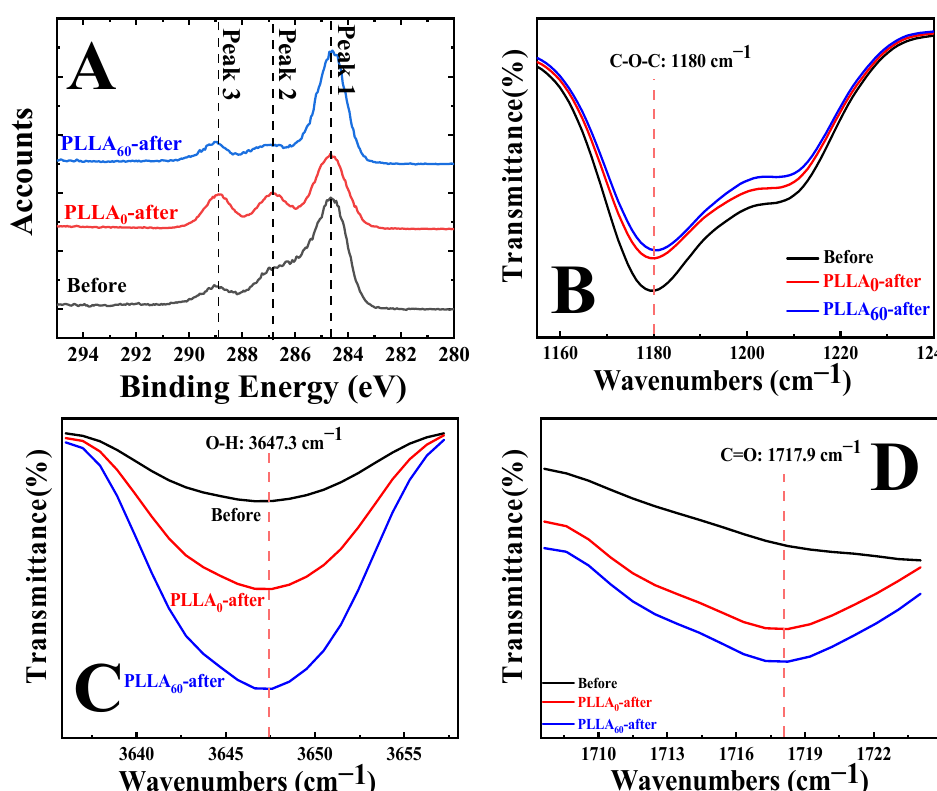
Figure 4. XPS C1s spectra ( A ) and FTIR spectra ( B – D ) of specimens before and after alkali hydrolysis of PLLA 0 and PLLA 60 .